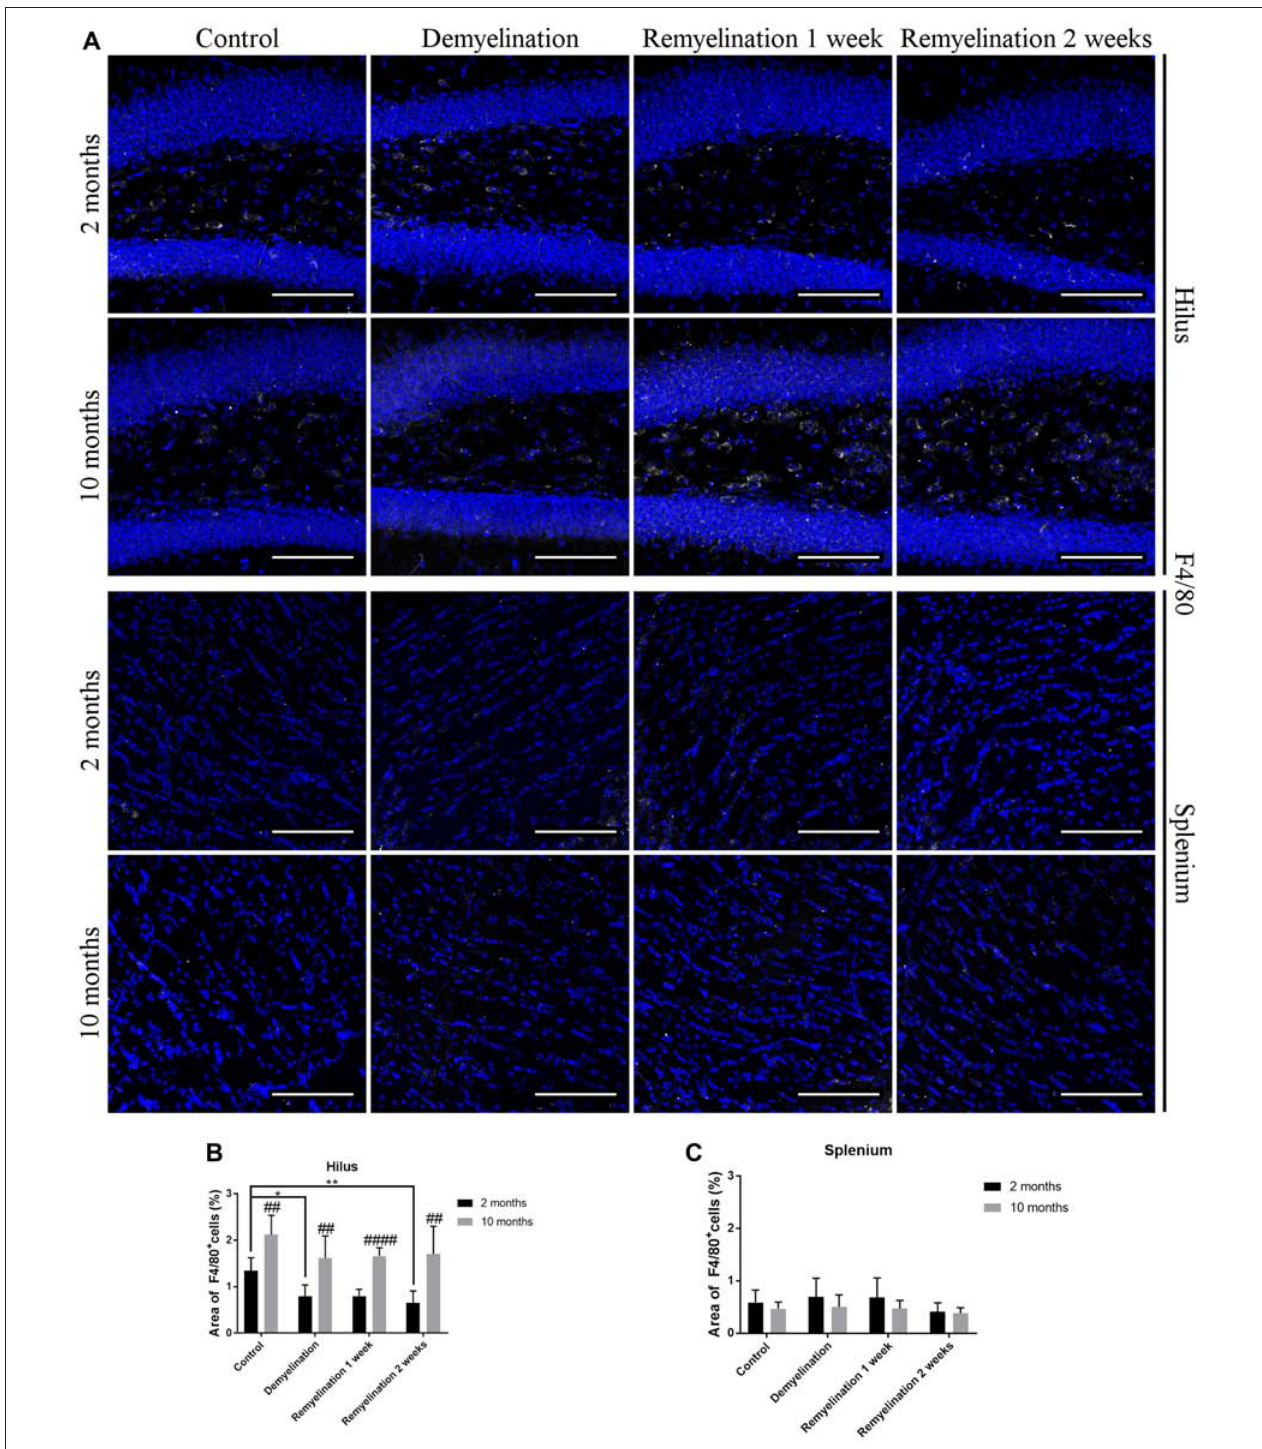
FIGURE 4 | F4/80 levels are affected by age and cuprizone treatment in the hilus of the DG, but not in the splenium of the CC. (A) F4/80 (white) staining in the hilus of the DG (two upper rows) and the splenium of the CC (two lower rows). Cell nuclei are stained with DAPI (blue). F4/80 is relatively low in all groups. (B) In the hilus of the hippocampal DG, F4/80 levels were higher in middle-aged groups compared to young ones. In young mice, F4/80 was significantly reduced after demyelination and 2 weeks of remyelination. (C) In contrast, in the splenium of the CC no significant changes in F4/80 expression were found. Values are shown as means + SD ( n = 6 per group). Statistical significance was evaluated using a two-way ANOVA followed by a Tukey’s post hoc test. The p -values are indicated in the graphs: treatment effects within the same age group: ∗ p < 0.05 and ∗∗ p < 0.01, age-related differences: ## p < 0.01 and #### p < 0.0001. Bars: (A) 100 µ m.